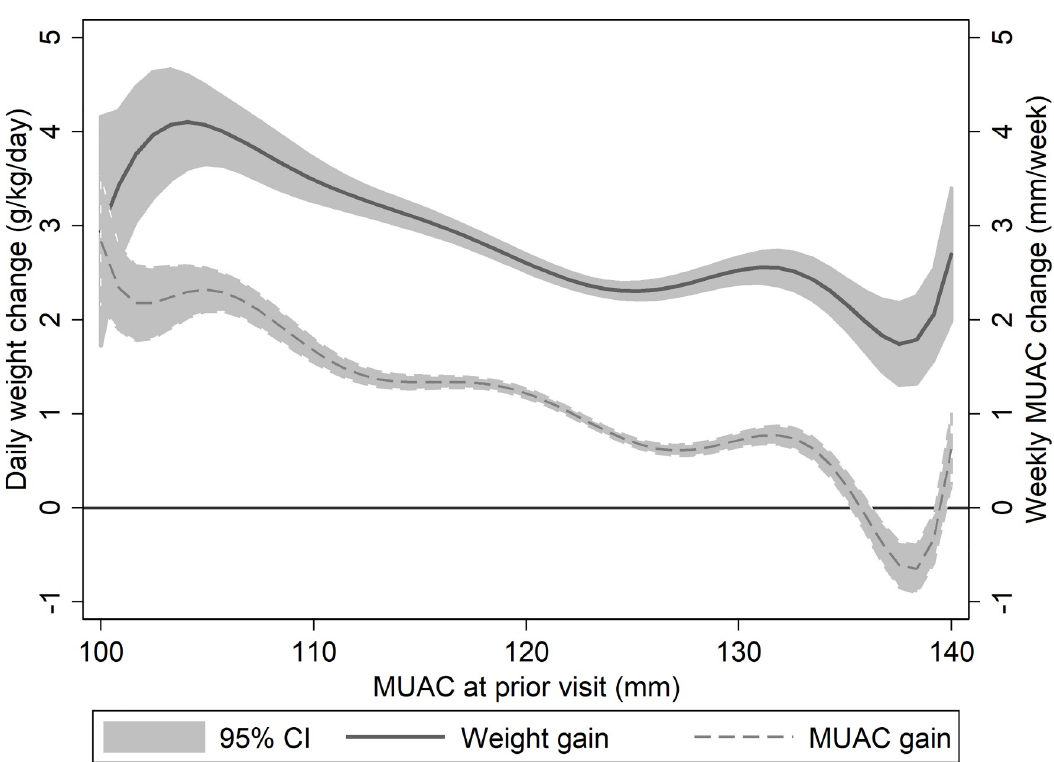
Fig 2. Average daily proportional weight change (solid line) and weekly MUAC change (dashed line) vs MUAC at prior visit.